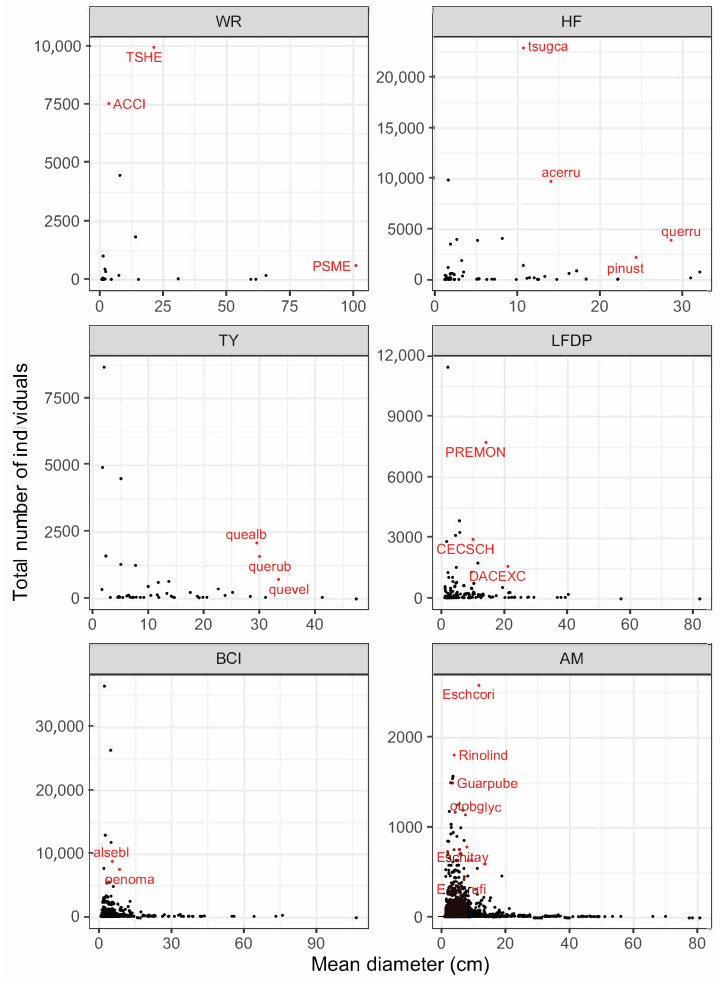
Figure 4. Size-frequency distributions of the species in each of the six studied ForestGeo plots. Panels are ordered from the northernmost temperate (top left) to equatorial (bottom right). Species that do not lie on the “reverse-J” line or that were otherwise are thought to be “important” species (in the tropical plots) are identified in red. Species abbreviations are given in Table 1.